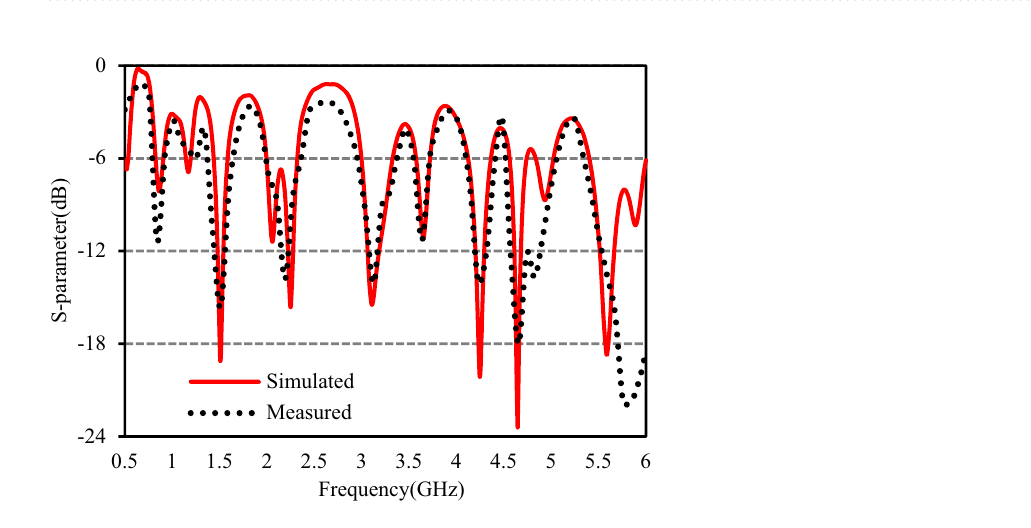
Figure 10. Simulated and measured